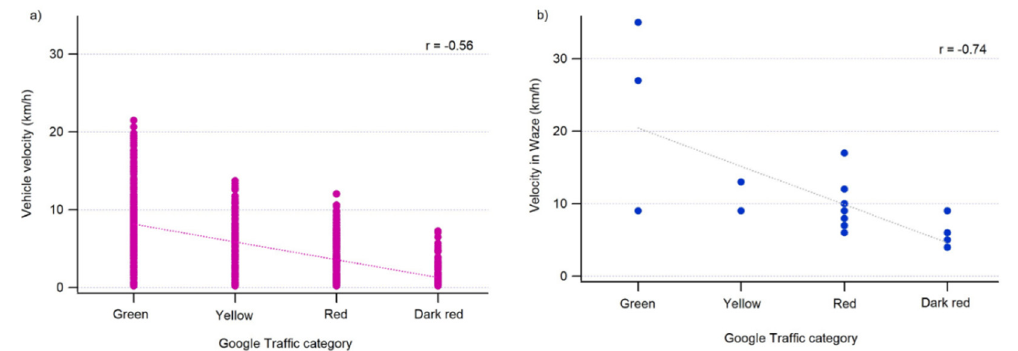
Figure 3. Linear correlation analysis of ( a ) real vehicle velocity measurements and traffic category in Google Traffic and ( b ) traffic velocity in Waze and traffic category in Google Traffic. Where Green represents fast-flowing traffic, Yellow—slower traffic with more vehicles, Red—more congested traffic, Dark red—the most congested or stopped traffic.